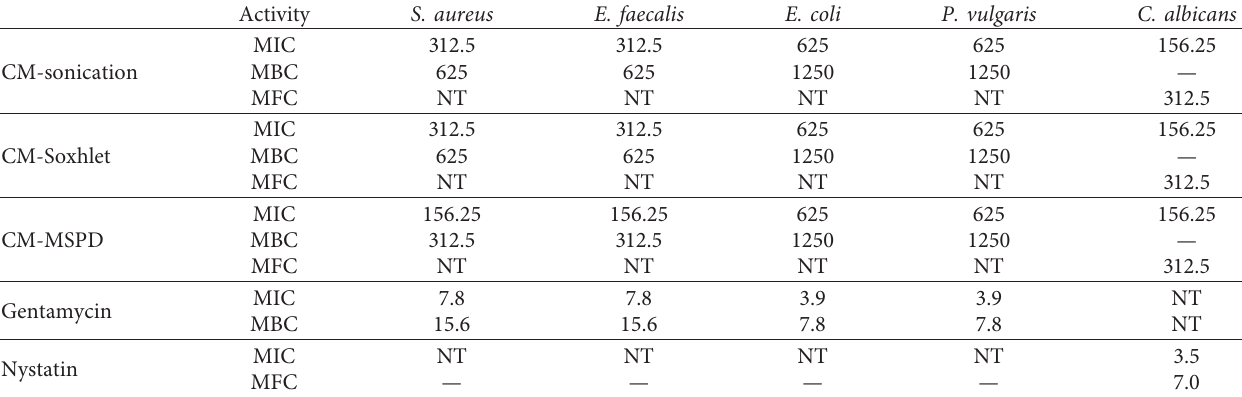
Table 4: Minimal inhibitory concentrations, minimal bactericidal concentrations (MBC), and minimal fungicidal concentrations (MFC) of the crude extracts of C. myrrha